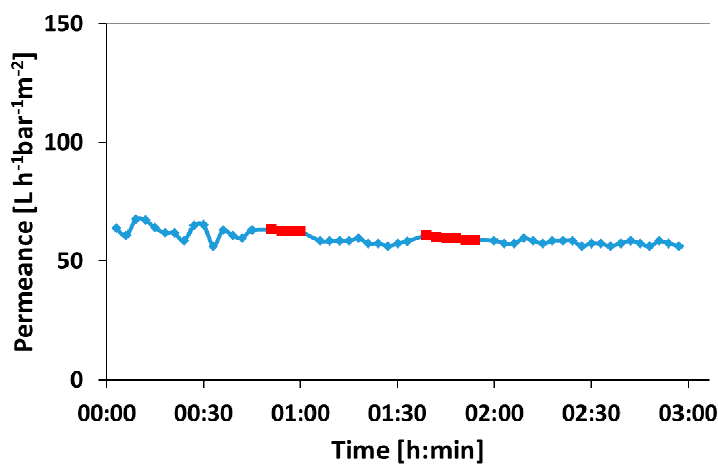
Figure A5. A pressure test of the roller coated PS 83 - b -P4VP 17 _DOX 1001 _15s did not show a significant change of permeance when changing the transmembrane pressure from 1 bar (blue diamond) to 5 bar (red square) and backwards. The permeance stayed around 60 L·bar − 1 ·h − 1 ·m − 2 . The membrane is therefore highly flexible and resists transmembrane pressures of 5 bar or more.